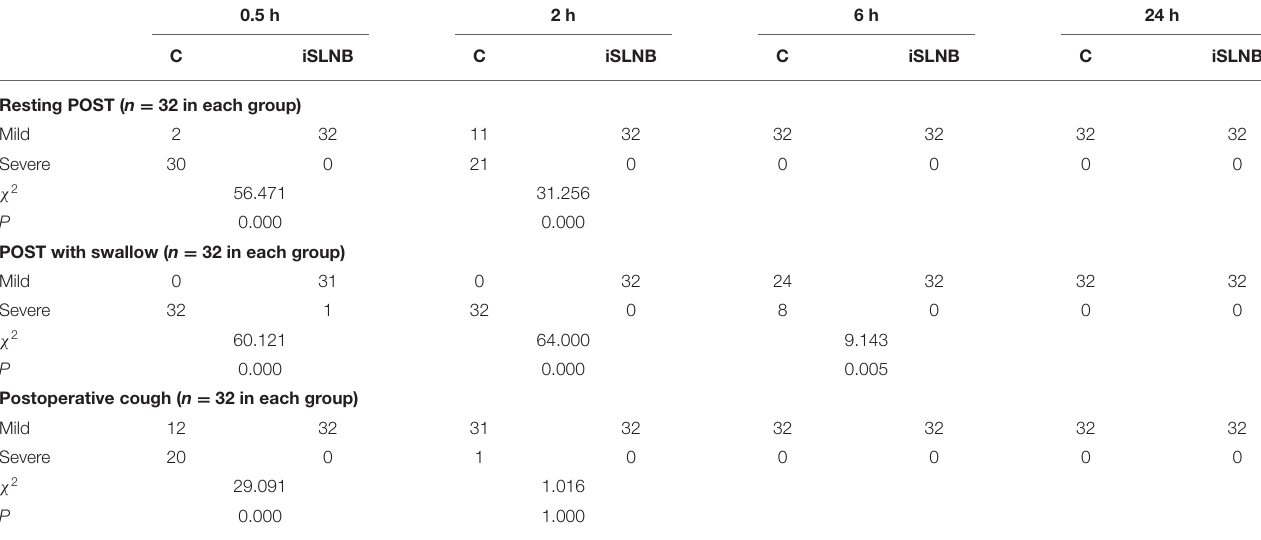
TABLE 3 | The incidences and severity of POST and cough.